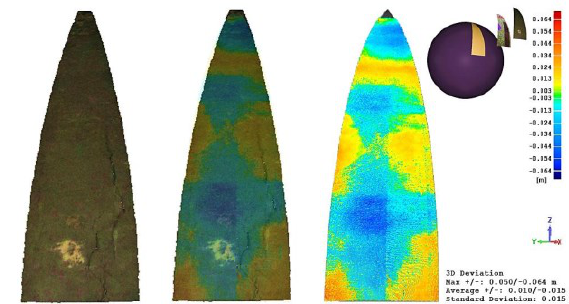
Figure 10. The deviations between the ideal and actual surface